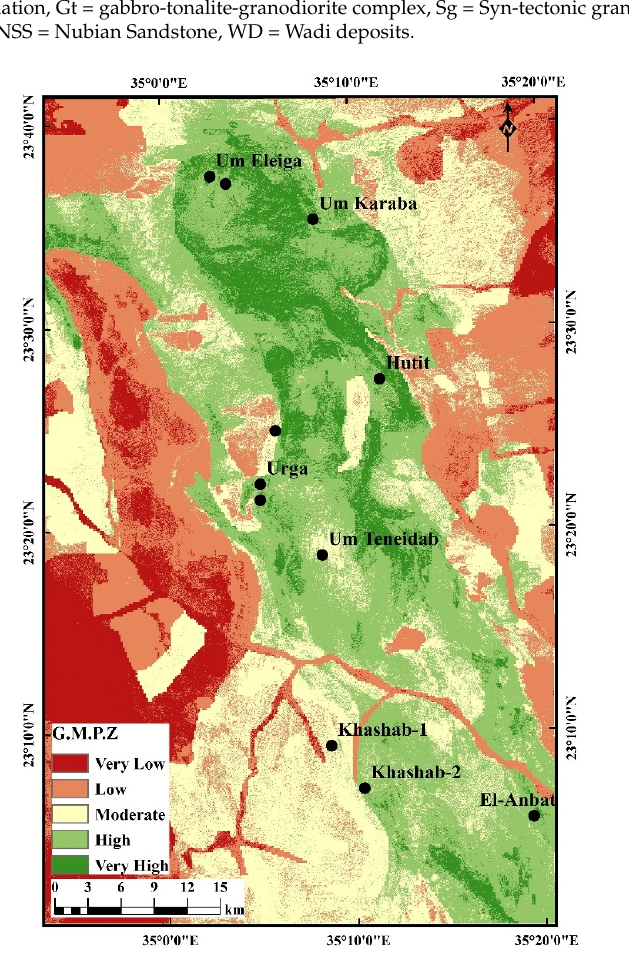
Figure 8. Gold mineralization potential zones (G.M.P.Z) map of the study